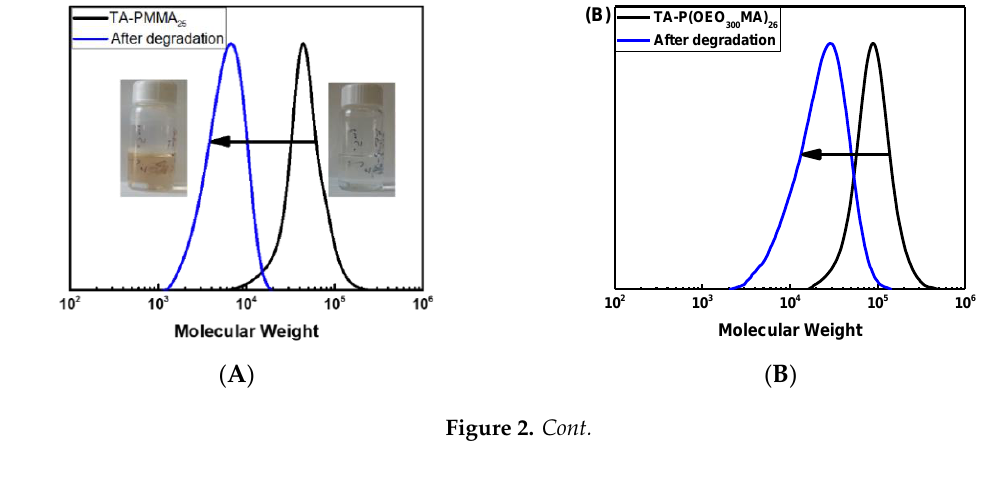
1 Conditions: MMA/TA-Br/CuBr 2 /Me 6 TREN = target DP/1/1/6; [MMA] = 0.9M; Solv. = DMSO by photo / Me = target DP / 1 / 1 / 6; [MMA] = 0.9M; Solv. = DMSO by photo ATRP ATRP (λ max = 365 nm; 5.2 mW/cm 2 ). 2 Determined by 1 H NMR conversion and assuming 25 arms per 1 Conditions: MMA / TA-Br / CuBr 2 6 TREN ( λ max = 365 nm; 5.2 mW / cm 2 ). 2 Determined by 1 H NMR conversion and assuming 25 arms per Star. 3 For PMMA, Star. 3 For PMMA, THF GPC and for P(OEO 300 MA) DMF GPC ; linear PMMA Standards. 3 THF GPC and for P(OEO